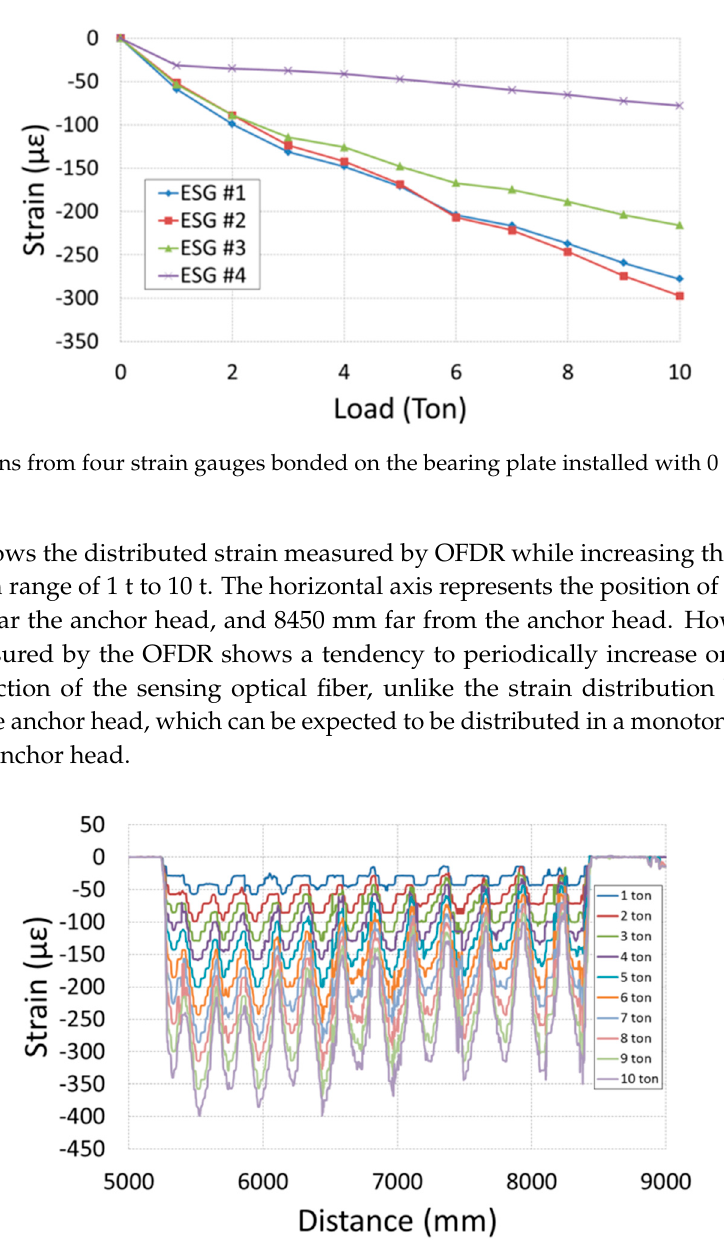
Figure 10. Strains from the sensing fiber of OFDR sensor bonded on the bearing plate due to loads.